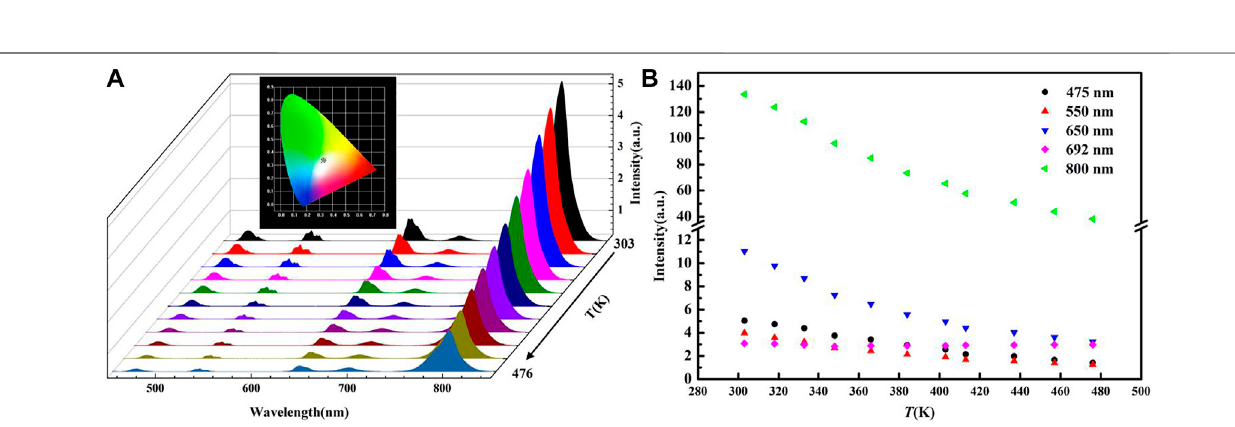
FIGURE 5 | (A) Up-conversion luminescence of the sample at different temperature, the inset shows the CIE chromaticity coordinates of the sample at different temperature; (B) temperature-dependent integrated intensity of the emissions located at different wavelength.